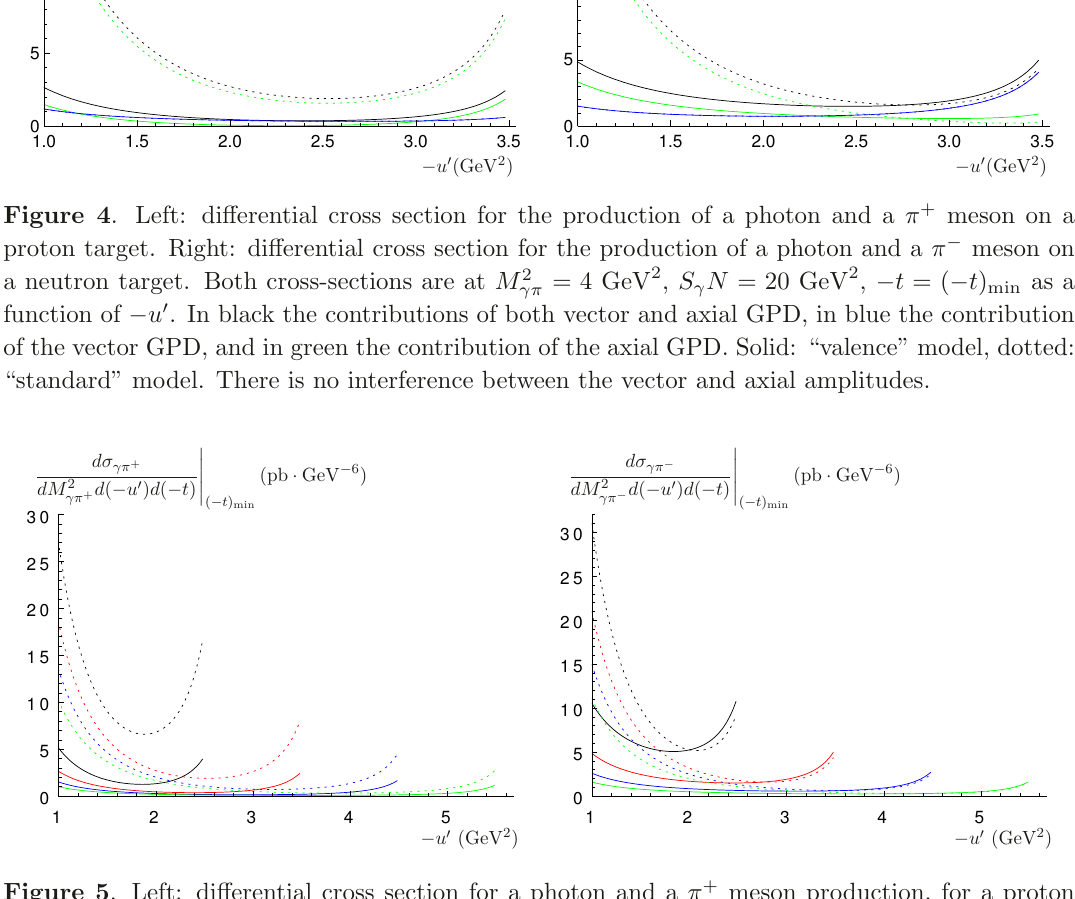
Figure 5 . Left: differential cross section for a photon and a π + meson production, for a proton target. Right: differential cross section for a photon and a π − meson production, for a neutron target. Both are displayed as function of u ′ , for M 2 = 3 , 4 , 5 , 6 GeV 2 (resp. in black, red, blue, γπ − green, from top to down). Solid: “valence” model, dotted: “standard”